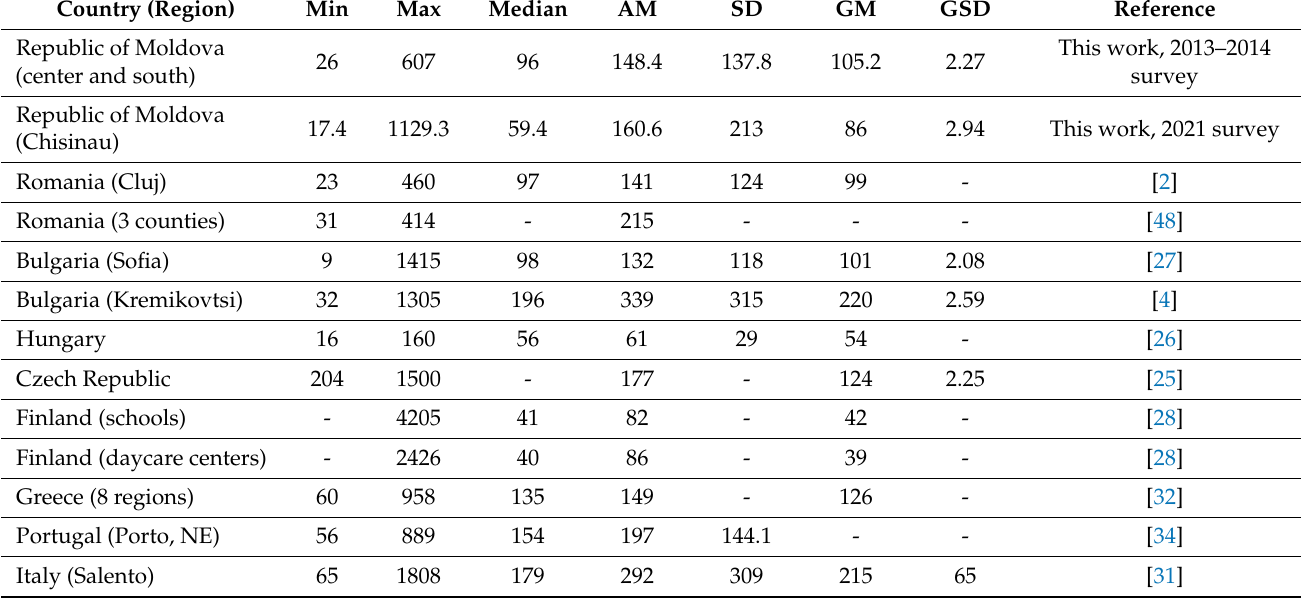
Table 2. Descriptive statistics of indoor radon measurements (in Bq m − 3 ) in educational institutions from different European countries.